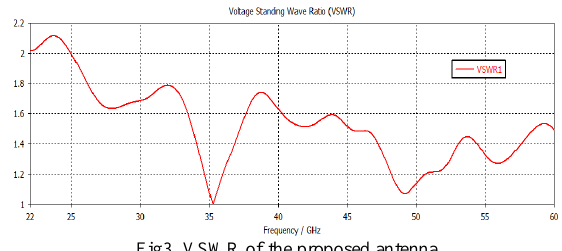
Fig3. VSWR of the proposed antenna